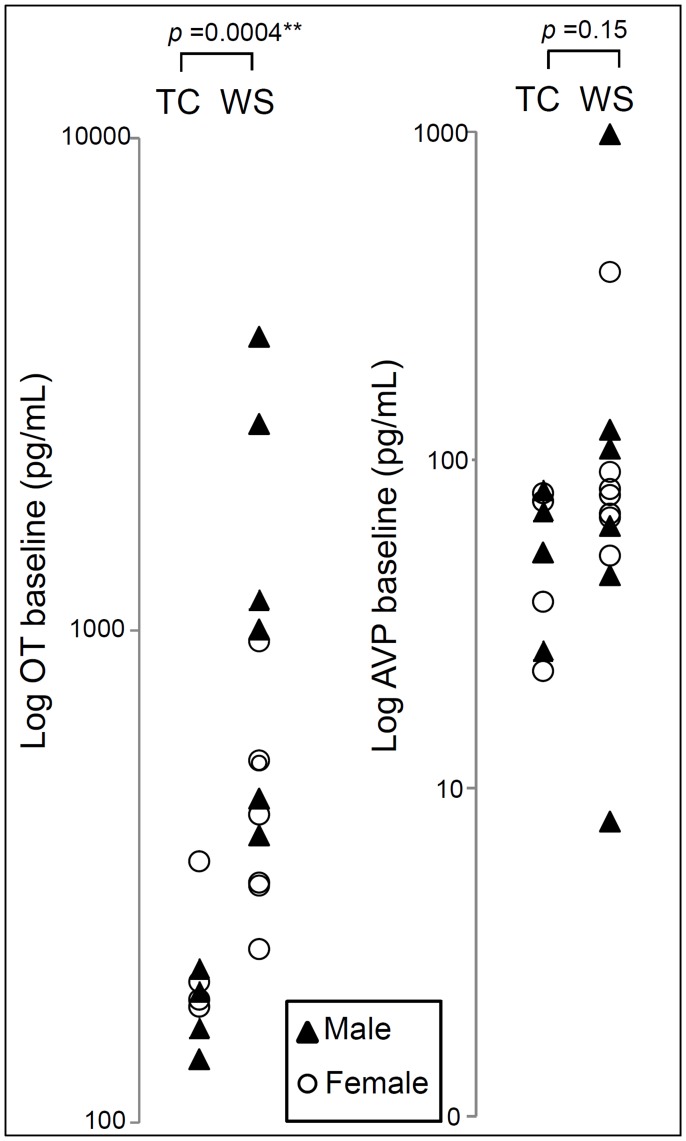
Comparison of basal neuropeptide levels in WS versus TC on the logarithmic scale.WS (n = 13) subjects show 3-fold higher median basal OT (P = 0.0004, determined by the Wilcoxon rank-sum Test) and 1.3-fold higher AVP (P = 0.15) levels versus TC (n = 8). Females are represented by open circles and males by solid triangles.